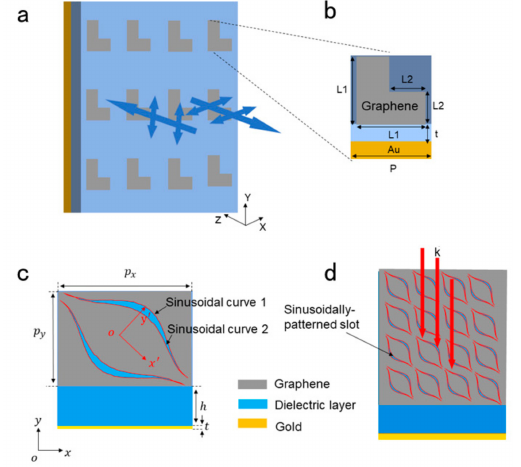
Figure 4. ( a ) Schematic of an ultrathin half-wave plate composed of an array of L-shaped graphene patches. ( b ) Square unit cell of the proposed design with the dimensions P = 3.6 µ m, L 1 = 2.4 µ m, L 2 = 1.2 µ m, and t = 7.5 µ m. ( c ) Unit cell of the proposed cross-polarization converter (CPC). Where the optimized parameters are, as follows: p x = 16 µ m, p y = 16 µ m, h = 25 µ m, and t = 0.4 µ m. ( d ) onfigurations of the proposed polarization